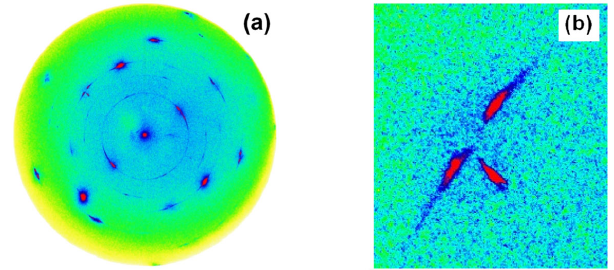
FIG. 3. (a) Example of Debye Scherrer rings as an indication for the small crystals in the LG disk of Ningxia OTIC company’s ingot. (b) Signal splitting of reflexes in the LG disk of Ningxia OTIC company’s